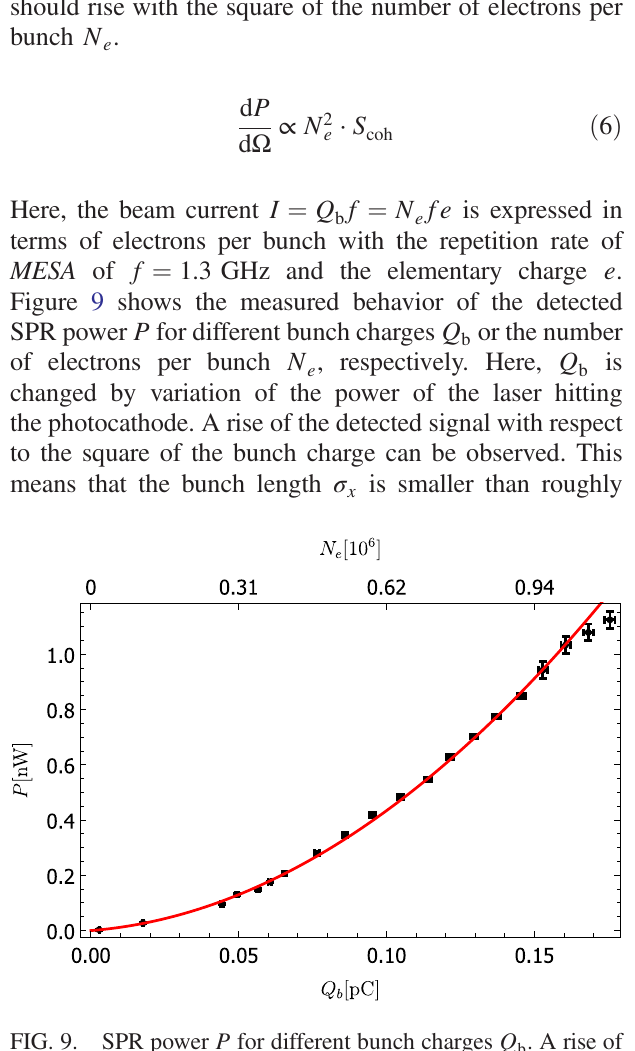
can be observed, proving that a coherent b